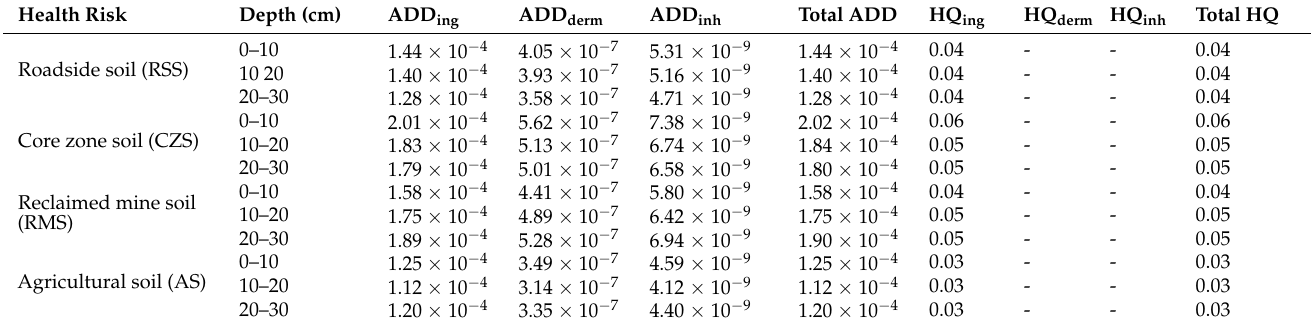
Table 5. Average daily dose (ADD) and hazard quotient (HQ) of Pb in three soil profiles